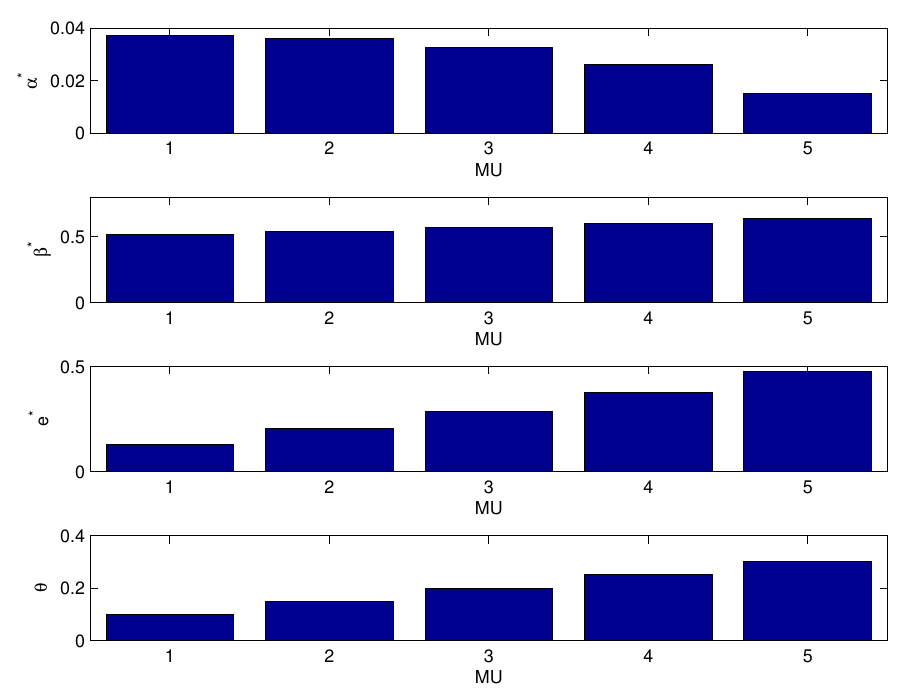
Figure 3. Mobile users’ (MUs’) optimal contract design with various θ i for fixed η M = 0.3, η S = 0.3, σ 2 = 1, c i = 0.4, and ¯ U =